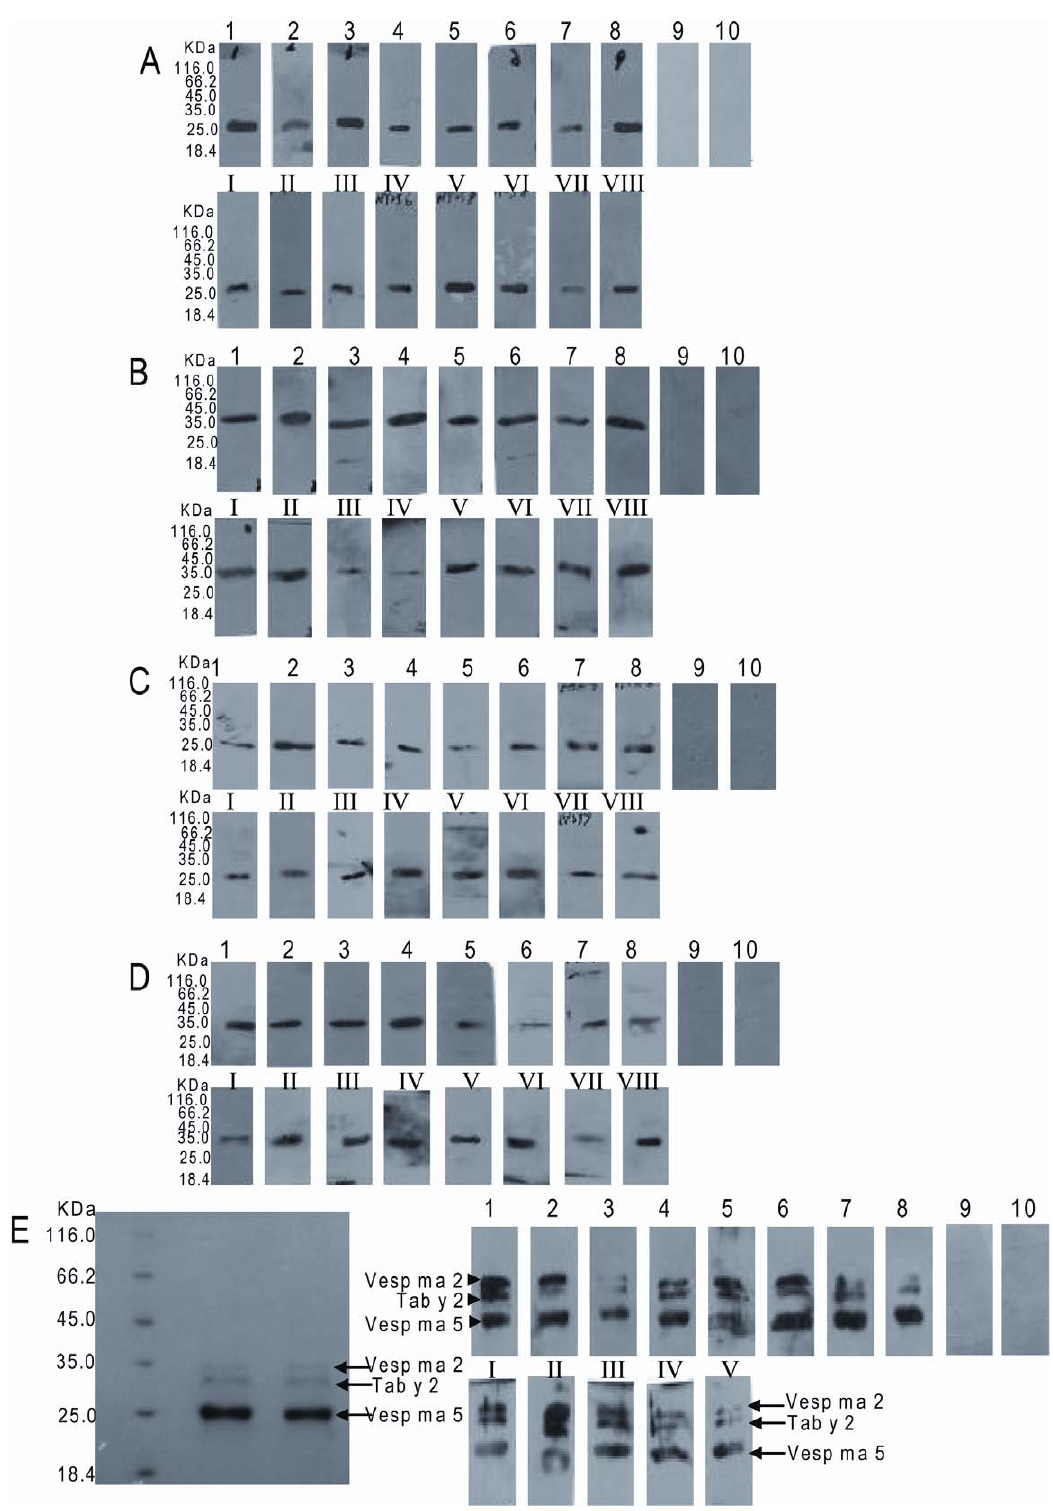
Figure 3. Immunoblot of IgE reactivity to Vesp ma 5(A), Vesp ma 2(B), Tab y 5(C), and Tab y 2(D). Lanes 1–8, representatives of subject serum from patients with wasp allergy; Lanes I–VIII, representatives of subject serum from patients with horsefly allergy; Lanes 9 and 10, negative controls. E : Three allergens (Vesp ma 5, Vesp ma 2, Tab y 2) were mixed and loaded on the same lane of SDS-PAGE ( Left ), and transferred to a nitrocellulose membrane for immunoblotting ( Right ). Comassie blue staining was performed to visualize proteins after PAGE-SDS. Note : Tab y 5 was not mixed with Vesp ma 5, Vesp ma 2, and Tab y 2 because it has the same molecular weight with Vesp ma 5.